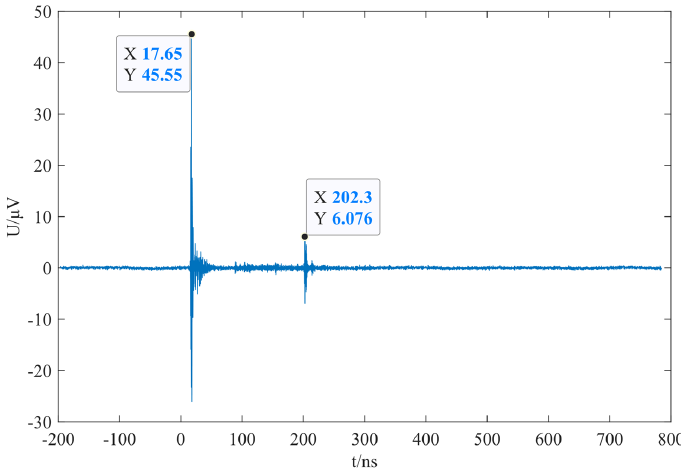
Figure 12. TDT test results.